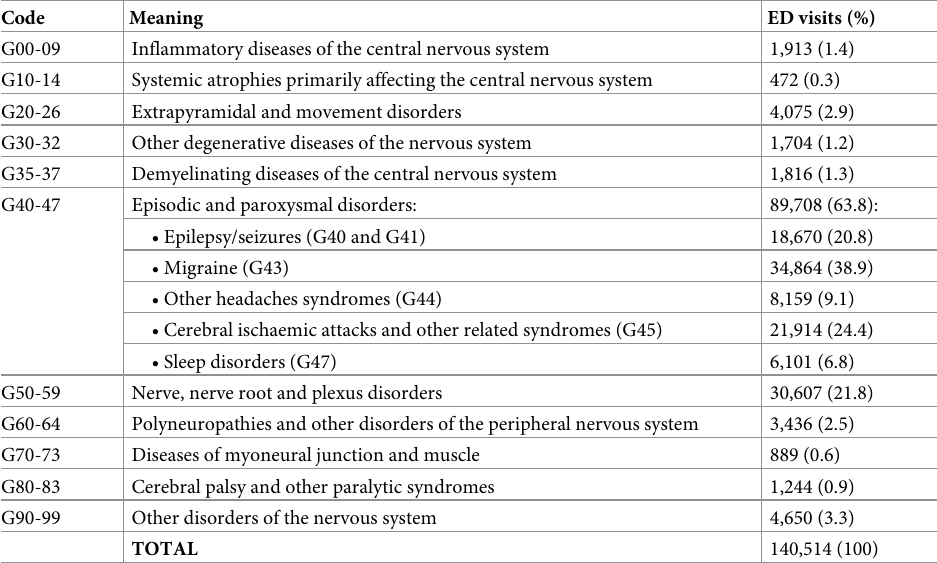
Table 2. Comparison of frequencies for each diagnostic sub-code